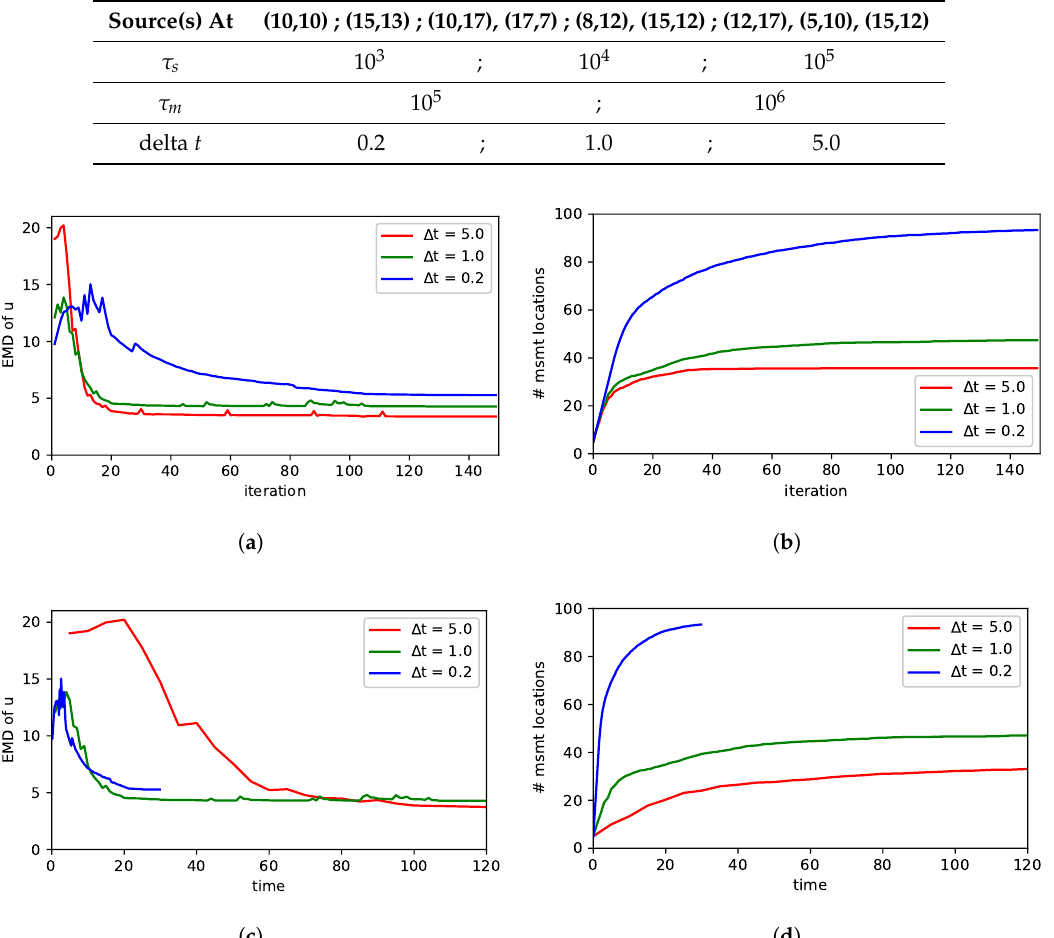
Table 4. Parameters used for simulation runs shown in Figure 7.